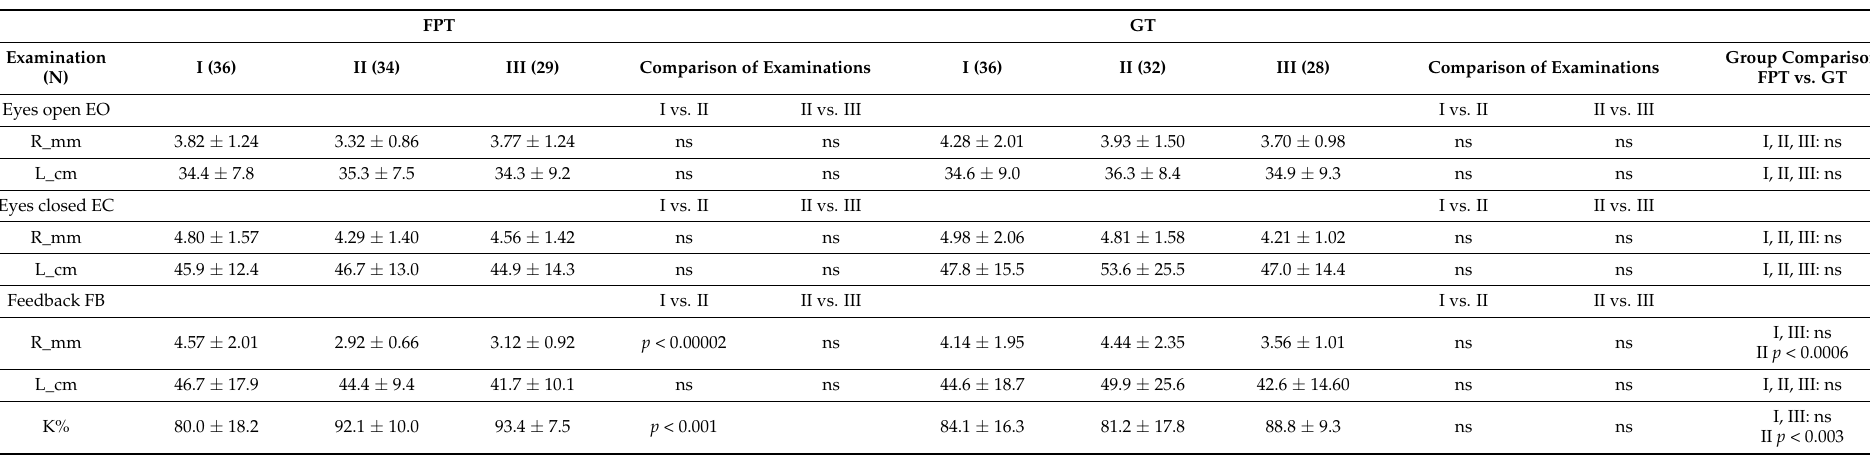
Table 2. Mean values with standard deviations of posturographic variables calculated for each type of measurement in each examination separately in both